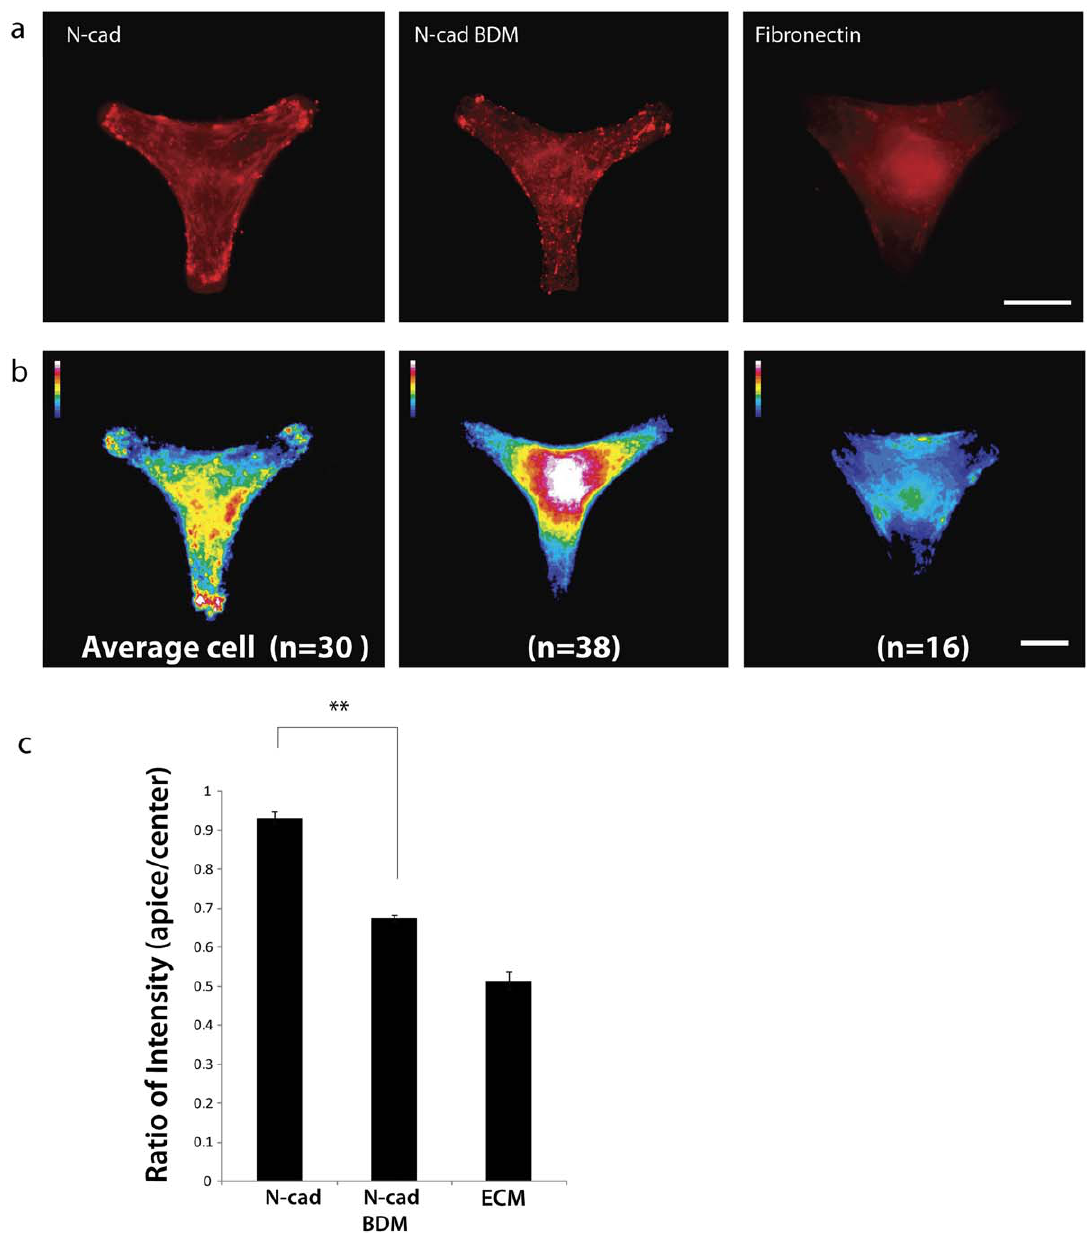
Figure 4. a -catenin localization is enhanced at the apices. (a)(Left to right) Representative images of cardiac myocytes stained for a -catenin (red) on N-cad patterns with and without BDM compared to Fn control; (b) (Left) Average cell of a -catenin stained cardiac myocytes on N-cadherin substrate (n=30 cells) shows localization at the apices, (center) N-cadherin substrate after addition of BDM, a myosin inhibitor (n=38 cells), note the absence of a -catenin localization at the apices and preferential localization to the perinuclear region, (right) Fn used as a control shows no preferential localization to the apices (white= most intense staining, blue=least intense staining); (c) Ratio of intensity of a -catenin staining on the apices of the Y-shaped micropattern to the intensity of a -catenin staining in the center of the micropatterns shows enhanced localization at the cell apices when contractility is not inhibited. **p , 0.01, error bars = 6 1 SEM. Scale bar indicates 20 m m.